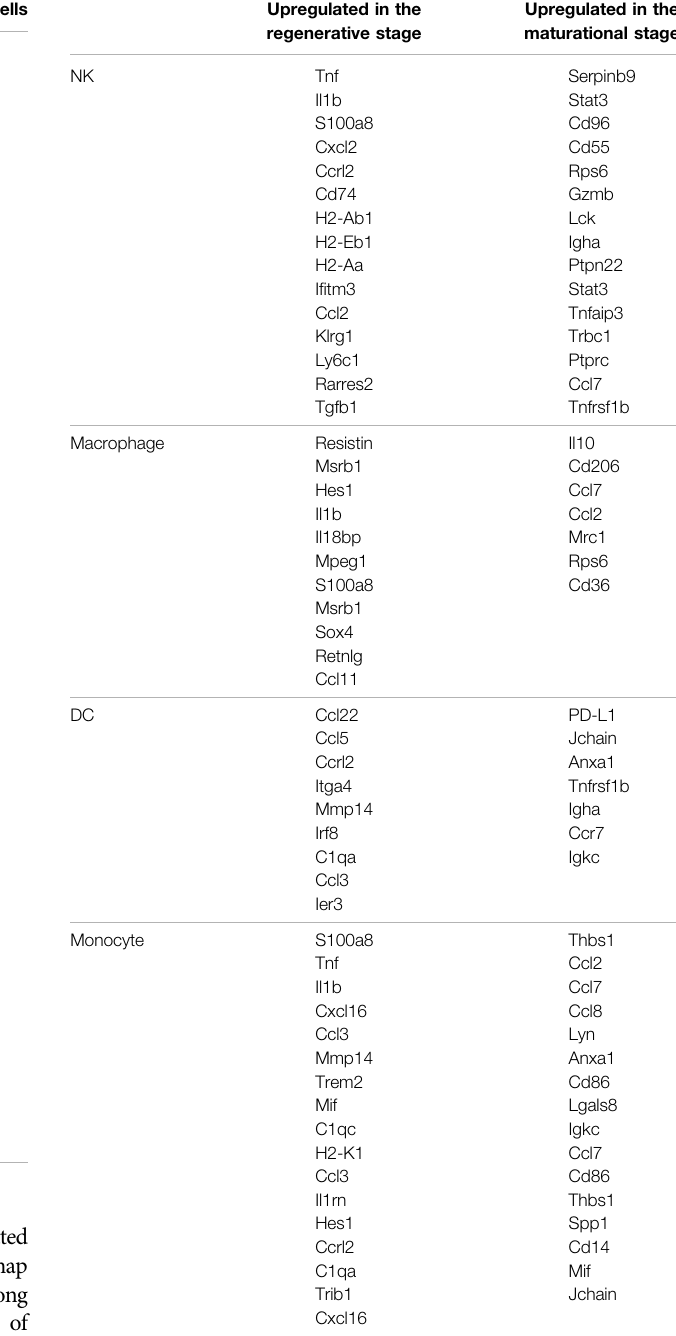
TABLE 3 | Signi fi cantly differentially expressed genes of immune cells in different physiological stages. Upregulated in the Upregulated in the regenerative stage maturational